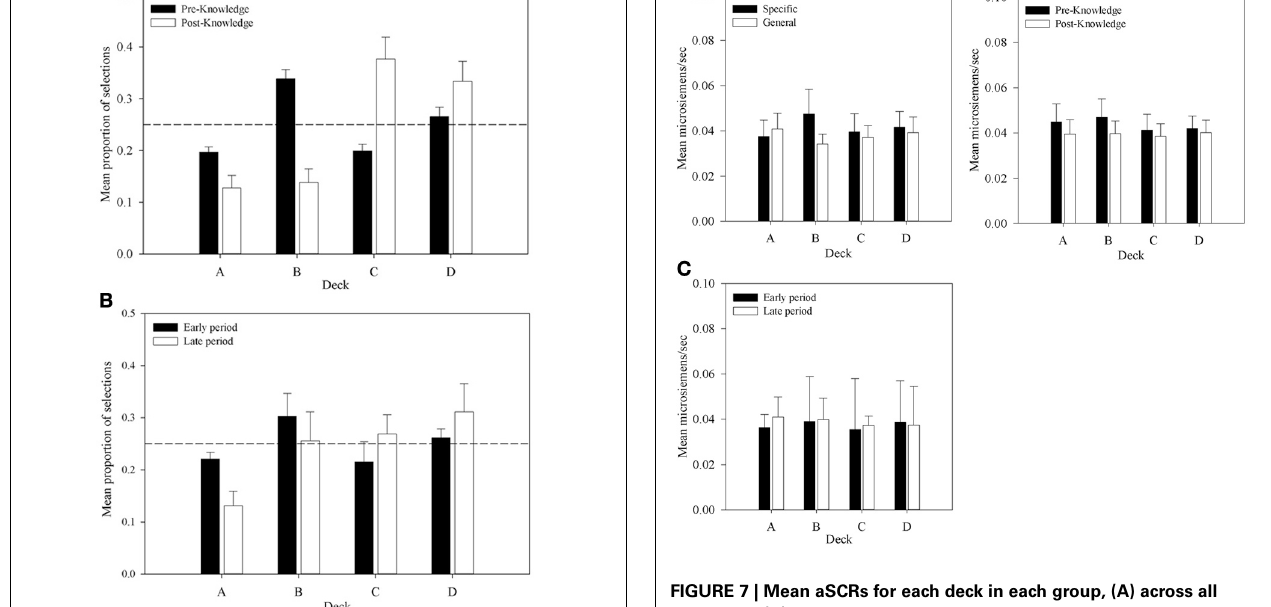
FIGURE 7 | Mean aSCRs for each deck in each group, (A) across all selections; (B) in selections prior to and following knowledge expression in those participants who displayed knowledge, and (C) the equivalent figure to b for participants who did not demonstrate knowledge—aSCRs before and after the mean trial at which knowledge was expressed in those who expressed knowledge (trial 39 in the Specific Group and trial 43 in the General group). Error bars are the standard error of the